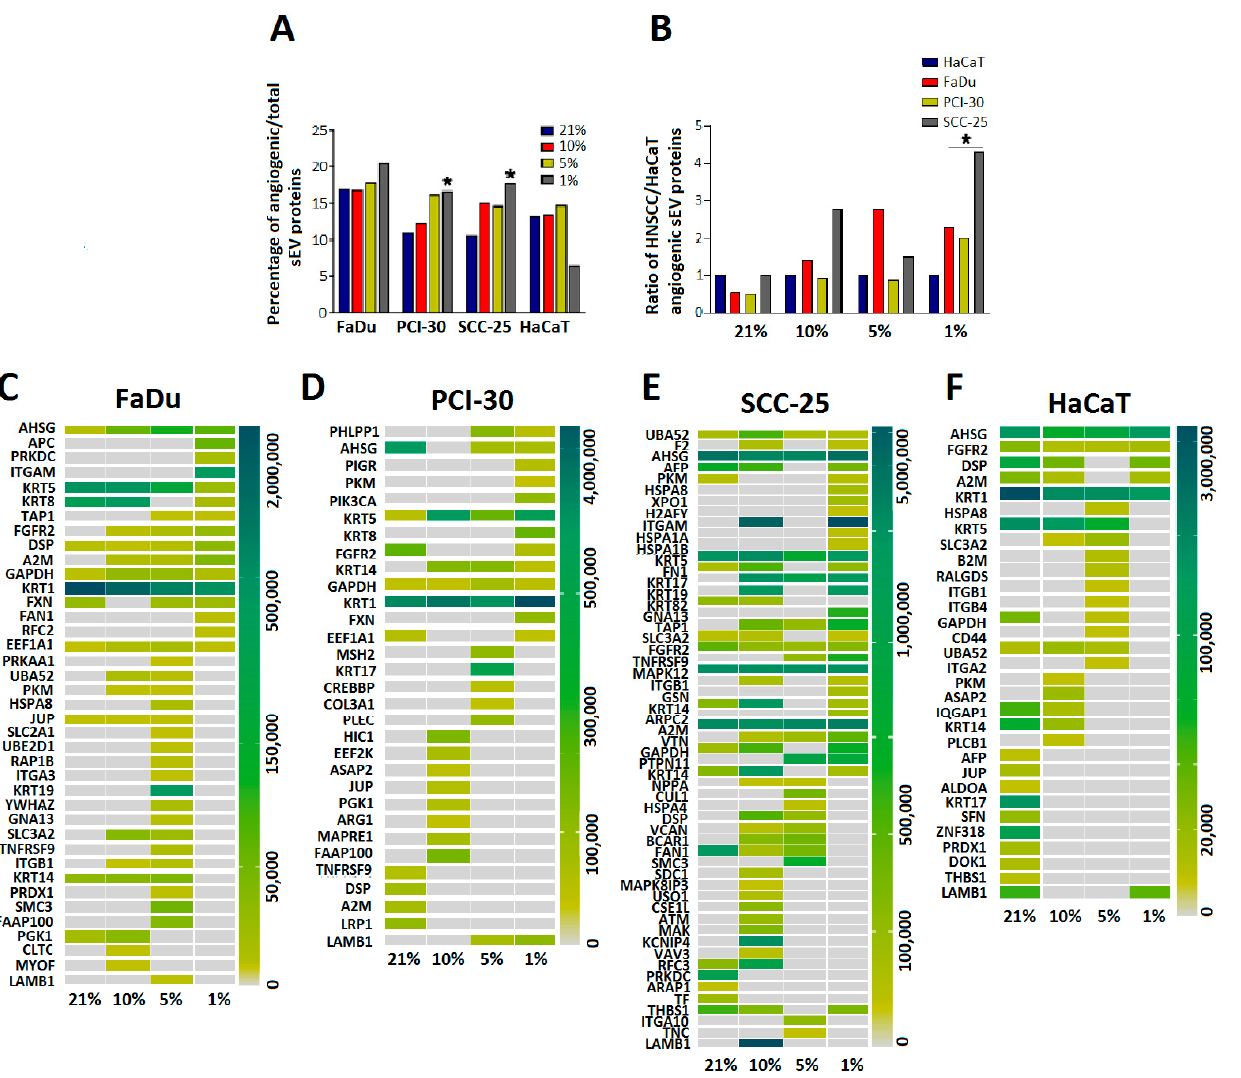
Figure 5. Characterization of pro-angiogenic proteins in small extracellular vesicles (sEVs). ( A ) Ratio of angiogenesis- related proteins to all proteins detected in sEVs deriving from indicated cell lines. * p < 0.05 vs. 21% O 2 . ( B ) Ratio of angiogenesis-related proteins in Head and Neck Squamous Cell Carcinoma (HNSCC)-derived sEVs to Human Keratinocyte (HaCaT)-derived sEVs, * p < 0.05 vs. HaCaT. ( C–F ) Abundance of angiogenesis-related proteins in sEVs deriving from indicated cell lines and oxygen levels.